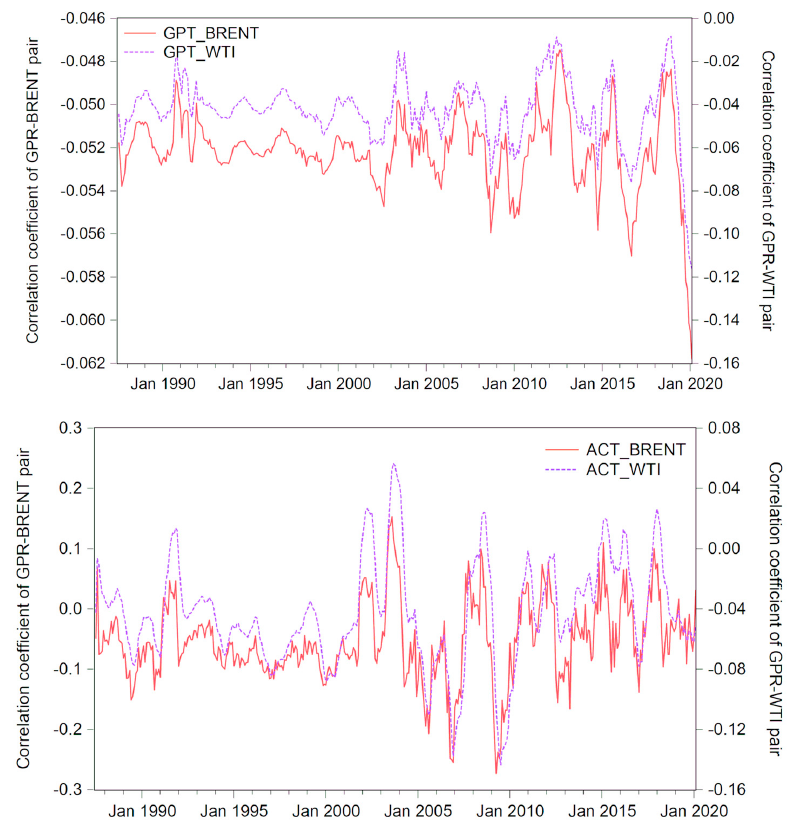
Figure 5. Dynamic correlations between the GPT / GPA indexes and crude oil prices. Note: the upper